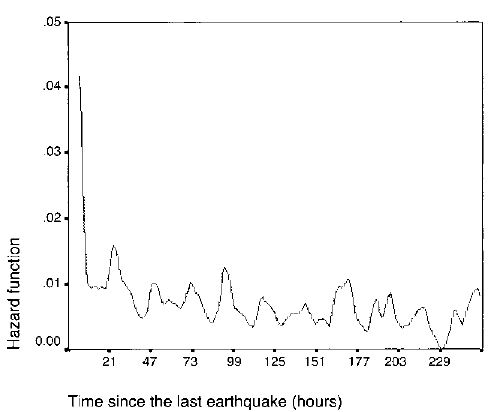
Fig. 7. Conditional hazard at t estimation for ln (cid:54) t ln (cid:54) t = 5.25 (dotted line). n